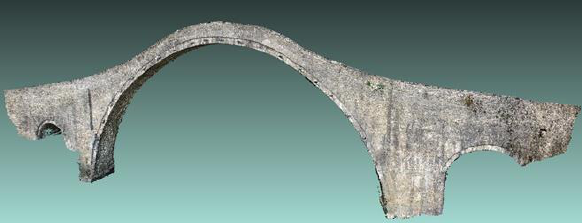
Figure 3. 3D point cloud of the bridge using crowdsourced images by (Stathopoulou et al.,